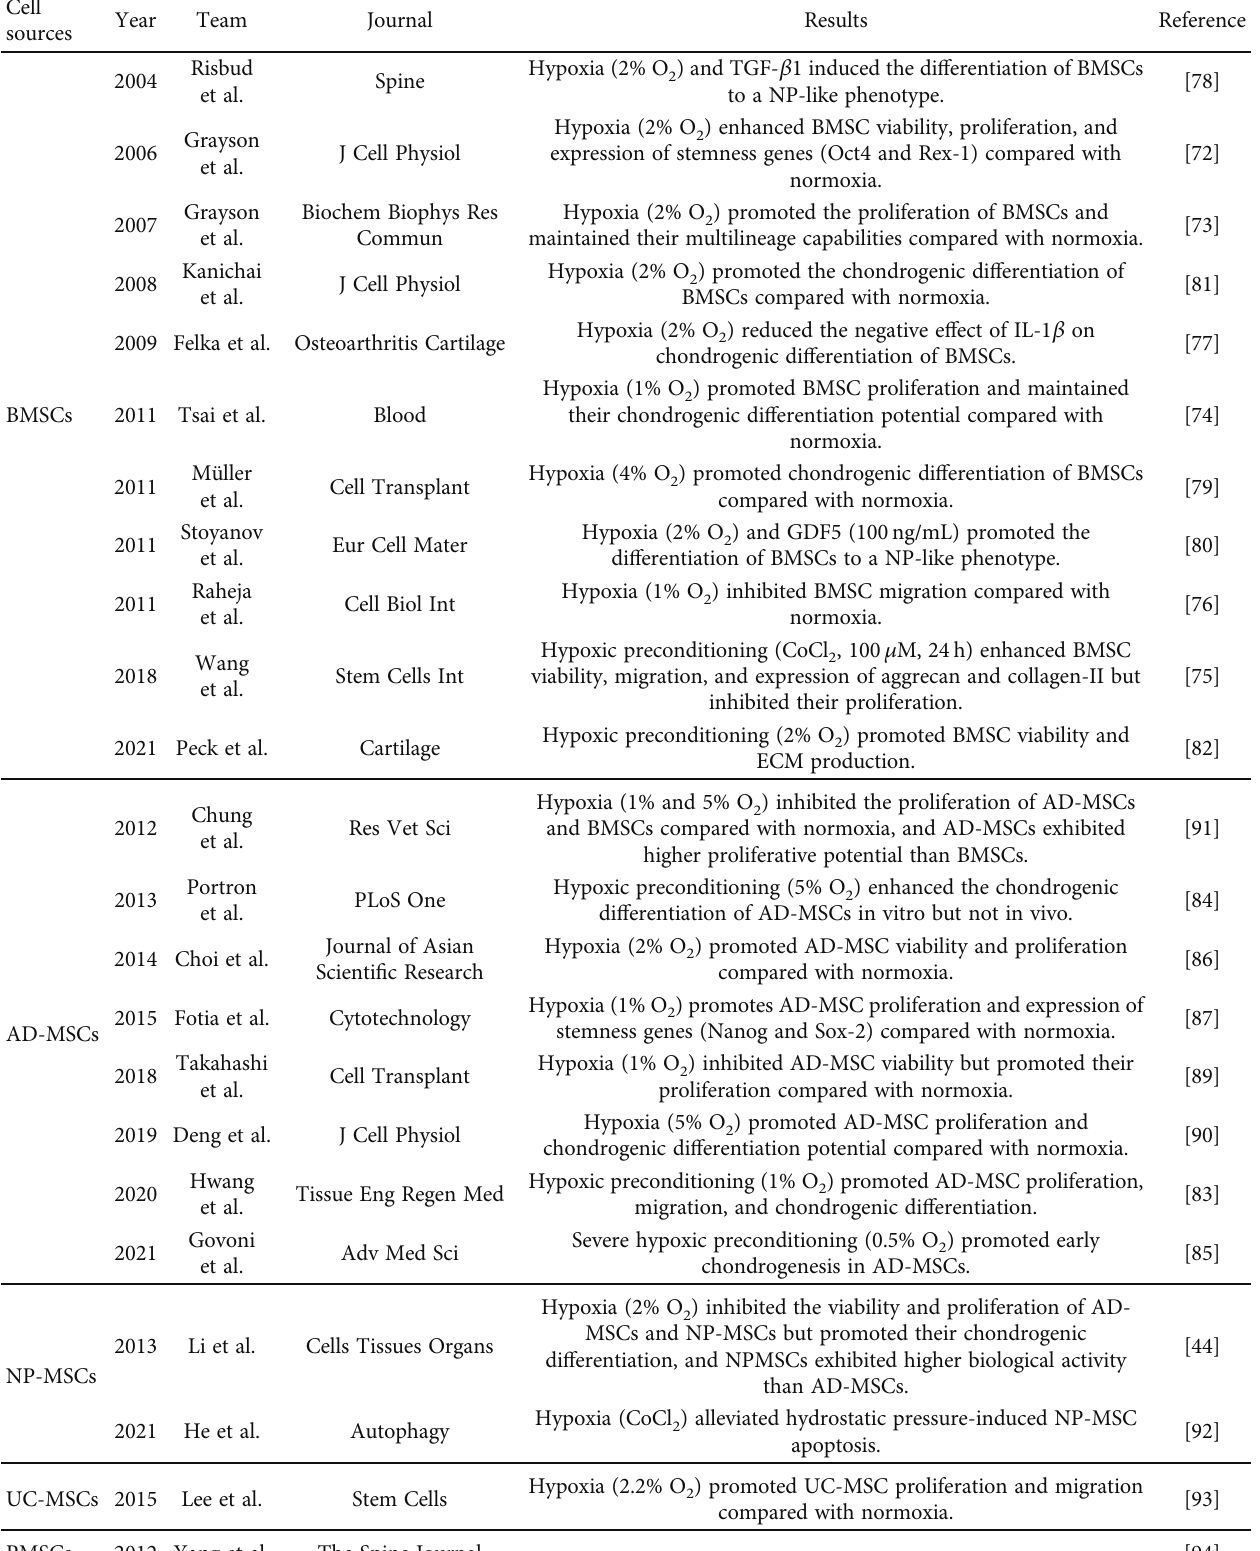
Table 2: E ff ects of hypoxia on the biological behavior of